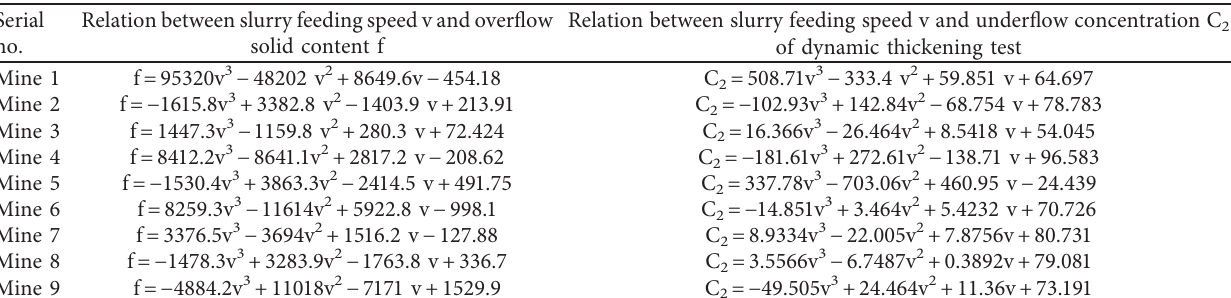
Table 4: The relation between slurry feeding speed and overflow solid content, and the relation between slurry feeding speed and underflow